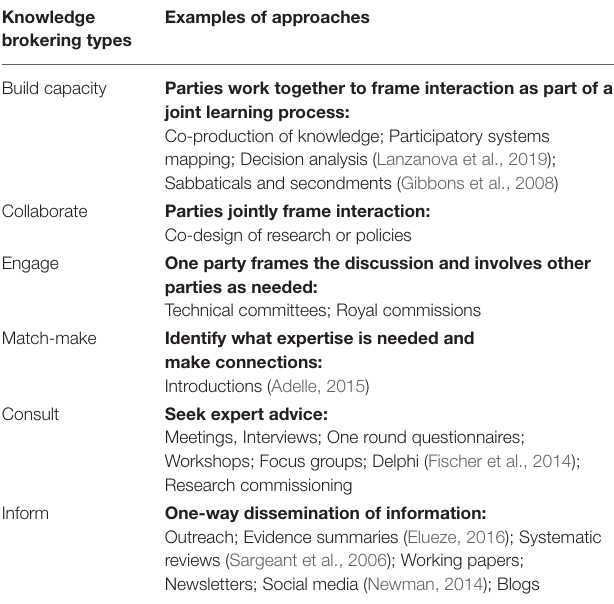
TABLE 2 | Spectrum of knowledge brokering approaches. Elaborated from Michaels